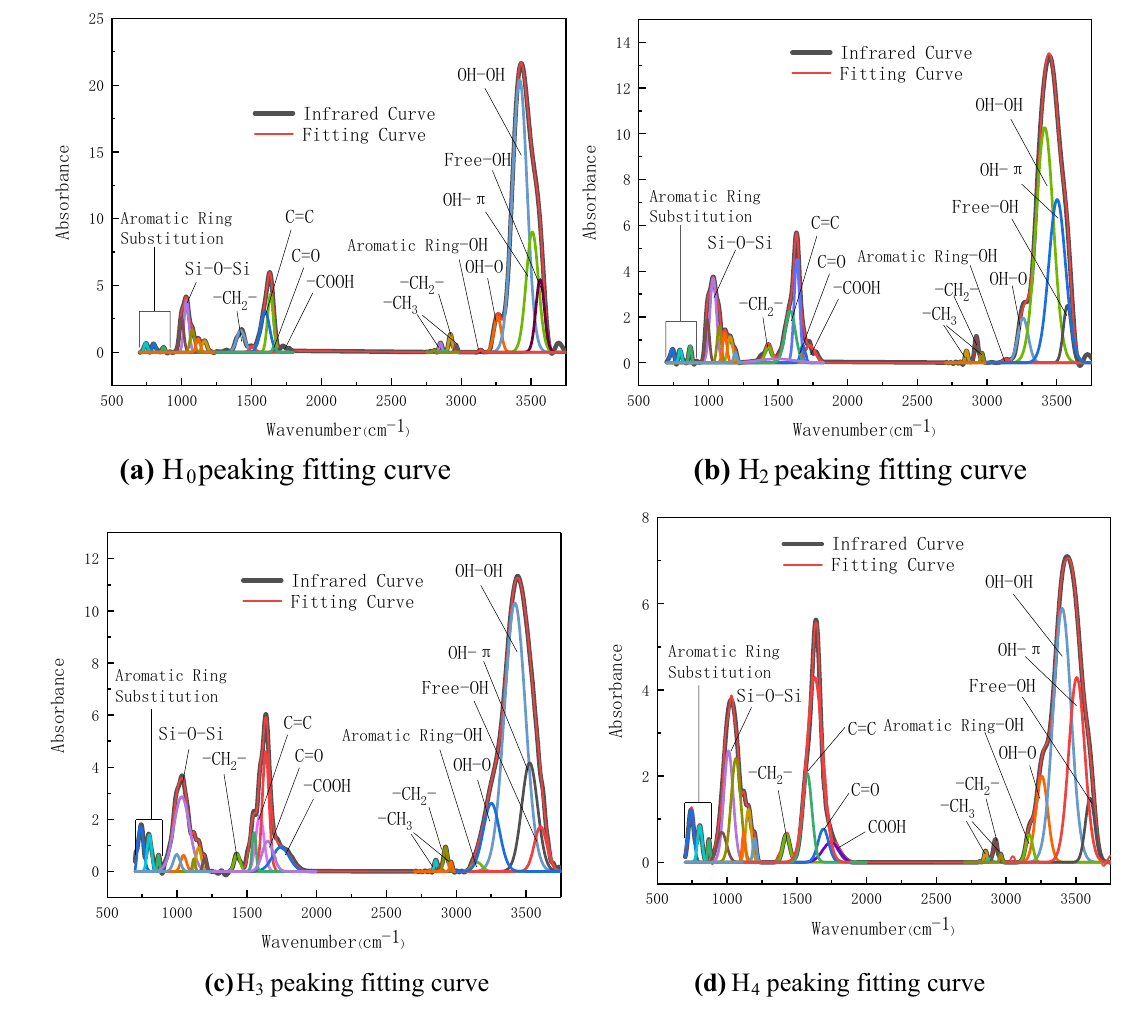
Figure 5. Peak fitting curve of high-sulfur coal.